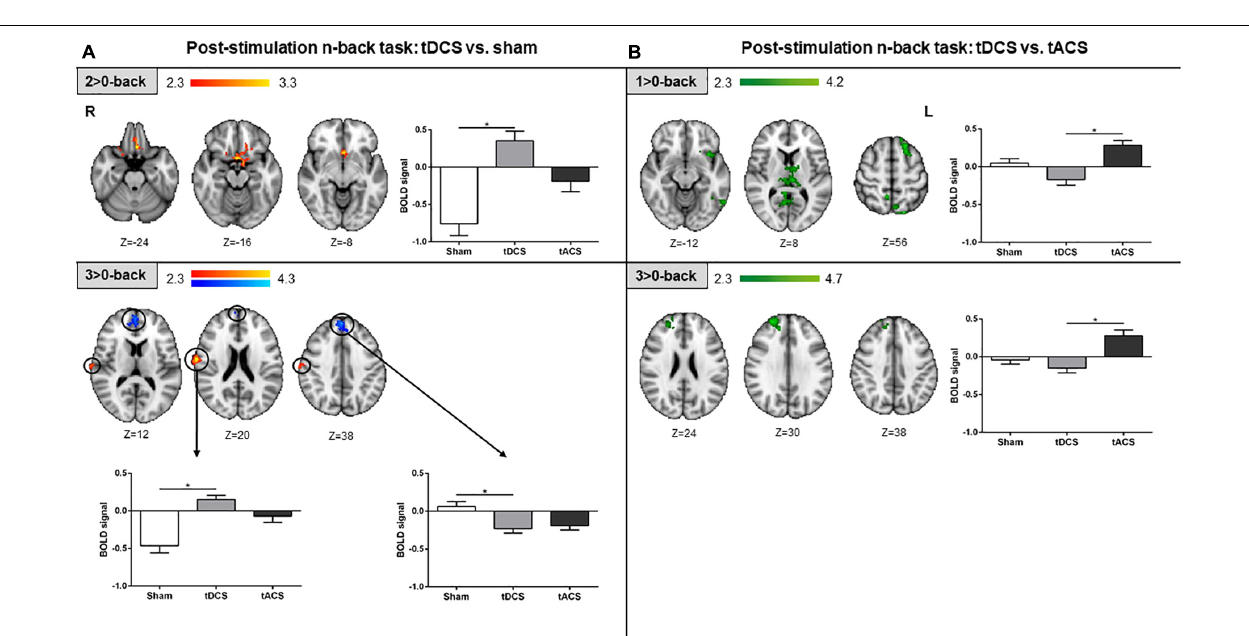
FIGURE 6 | Post-stimulation fMRI n-back task results. (A) tDCS vs. sham results are shown in red-yellow for higher activations and blue-light blue for lower activations. (B) tDCS vs. tACS results are shown in green. Left and up: statistically significant fMRI activity maps on the standard MNI for each contrast of interest and group comparison. Right and below: plots of mean BOLD signal values at the fMRI clusters considering sham, tDCS and tACS where significant differences between groups were found. Data are presented as mean with SEM . tDCS, transcranial direct current stimulation; tACS, transcranial alternating current stimulation; BOLD, blood oxygen level